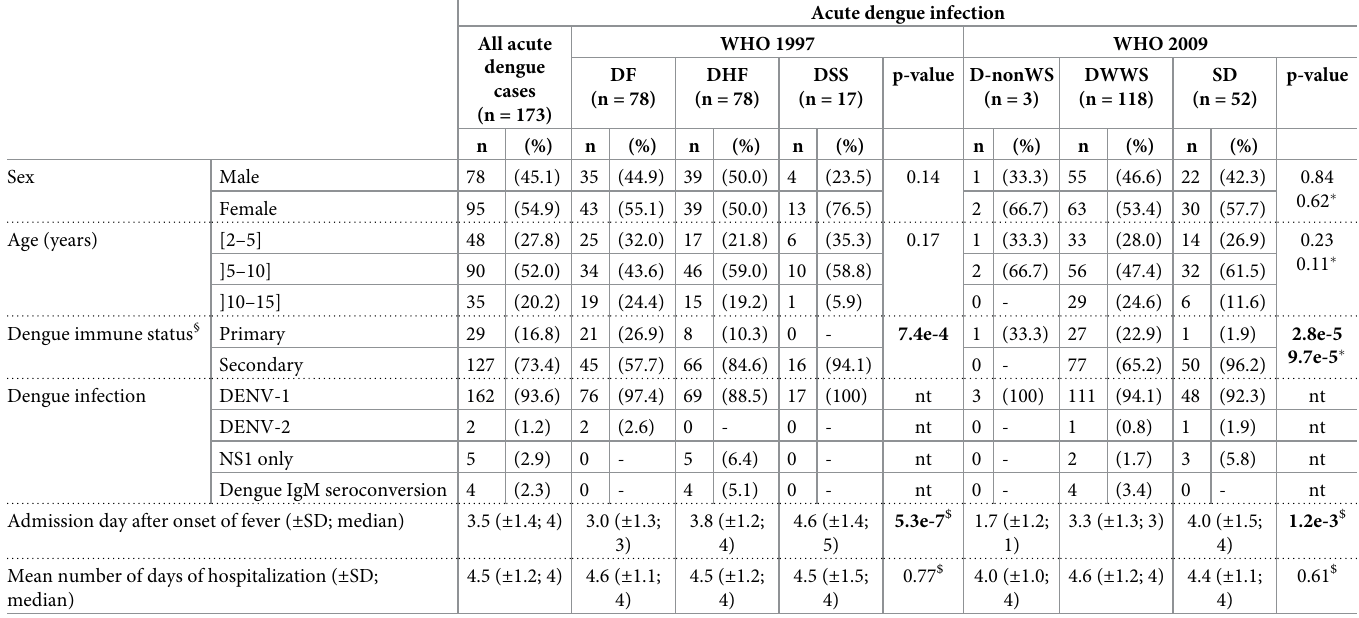
Table 2. Demographic (gender and age), dengue immune status, laboratory-confirmed dengue diagnosis and hospitalization duration of acute dengue-infected children included in the study in terms of the WHO 1997 and adapted WHO 2009 dengue classifications (n =